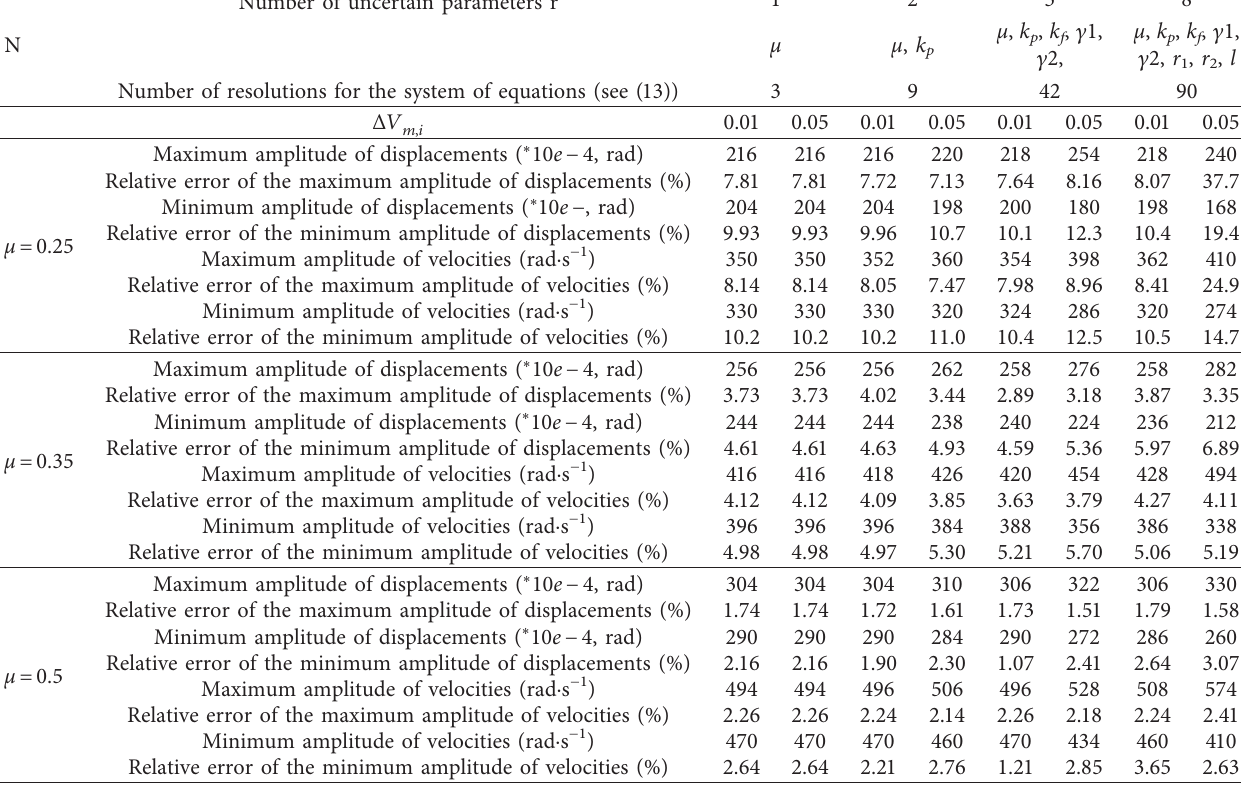
Table 3: Comparison of calculated limit cycles of a clutch system with 6 DOF, using different methods. Methods Relative error of the maximum amplitude of displacements (%) Relative error of the minimum amplitude of displacements (%) Relative error of the maximum amplitude of velocities (%) Relative error of the minimum amplitude of velocities (%)